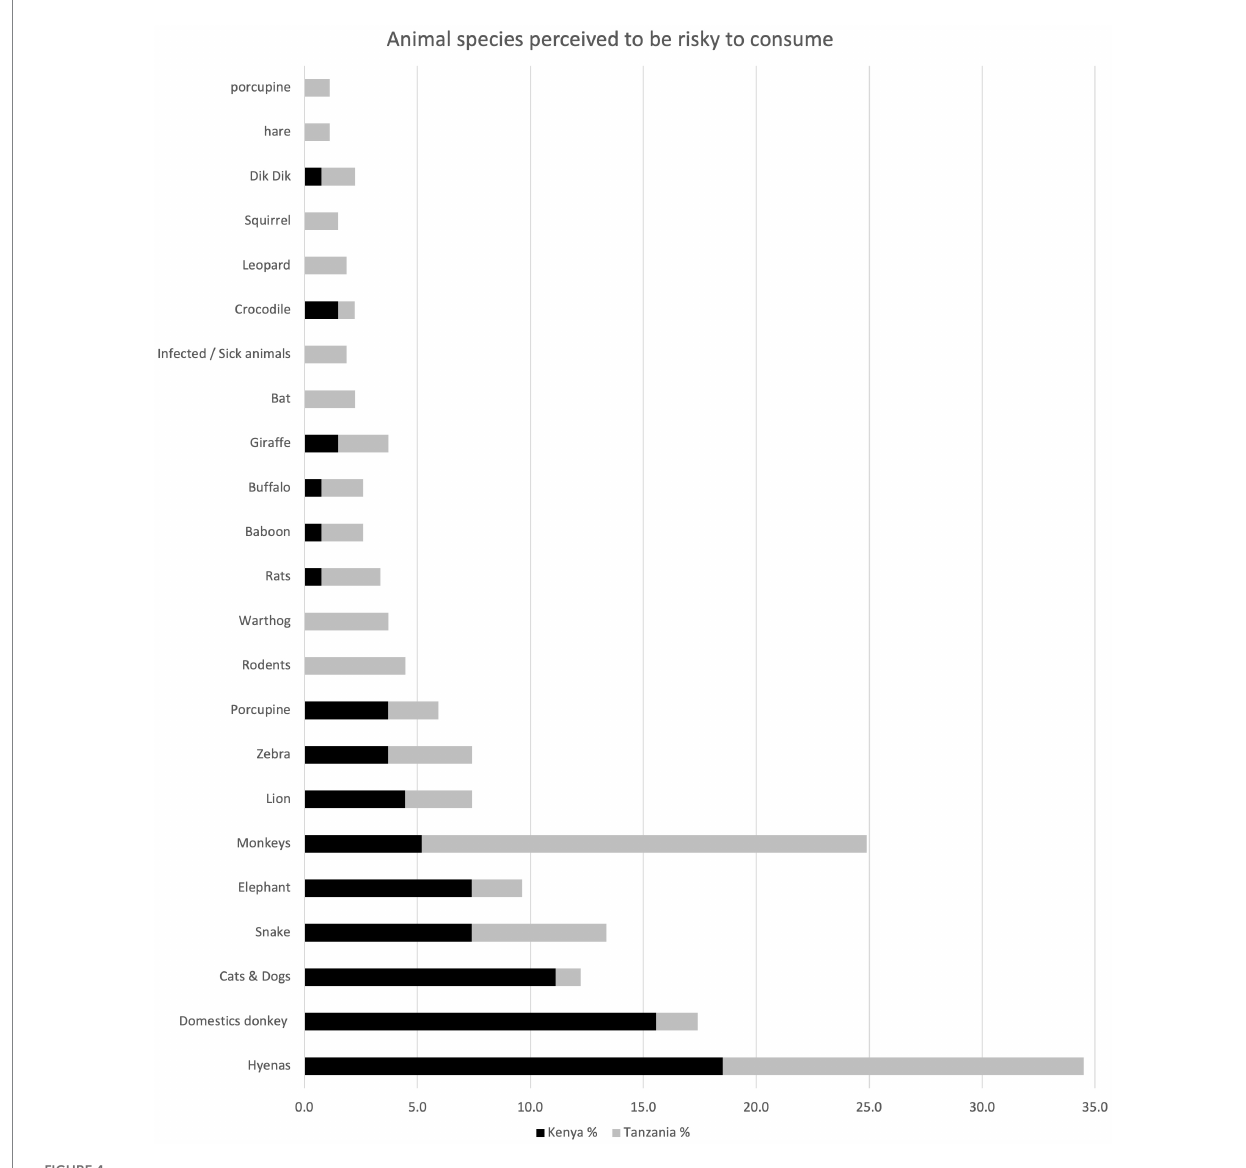
FIGURE 4 Species perceived by respondents as high